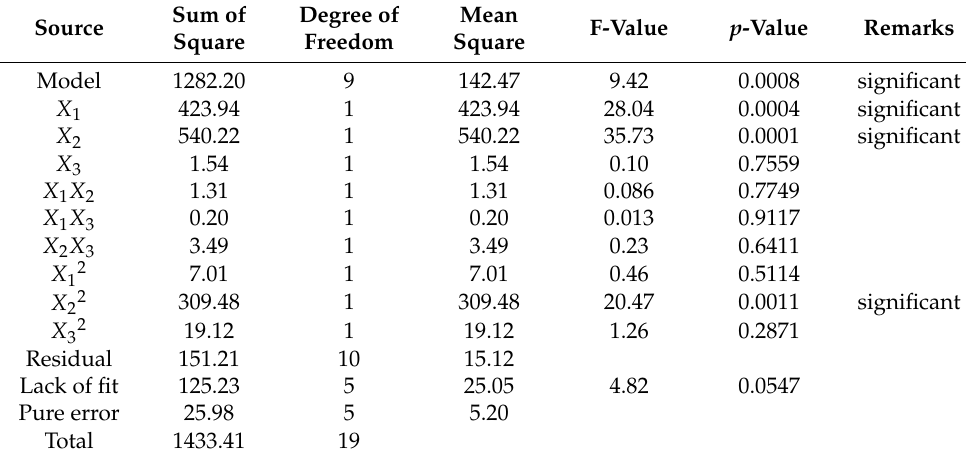
Table 5. ANOVA for response surface model of enzymatic digestibility (ED).